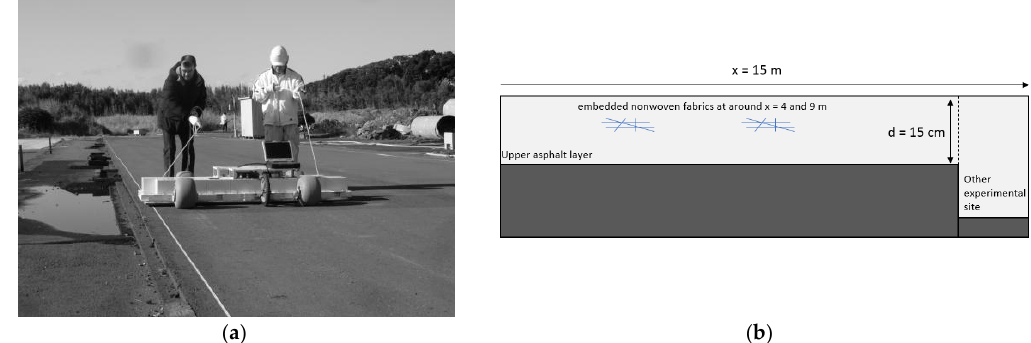
Figure 7. Data acquisition with Yakumo on the airport runway model at the Nobi experiment site. ( a ) Experiment site. ( b ) Pavement structure.